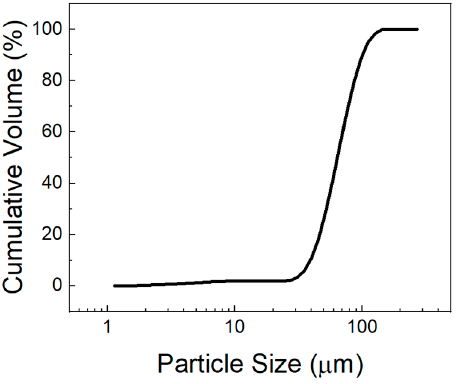
Figure 1. The size distribution of quartz used in flotation. Table 1. The chemical structures, chemical formula and HLB values of NaOL, OP ‐ 10, NP ‐ 10 and AEO ‐ 9.